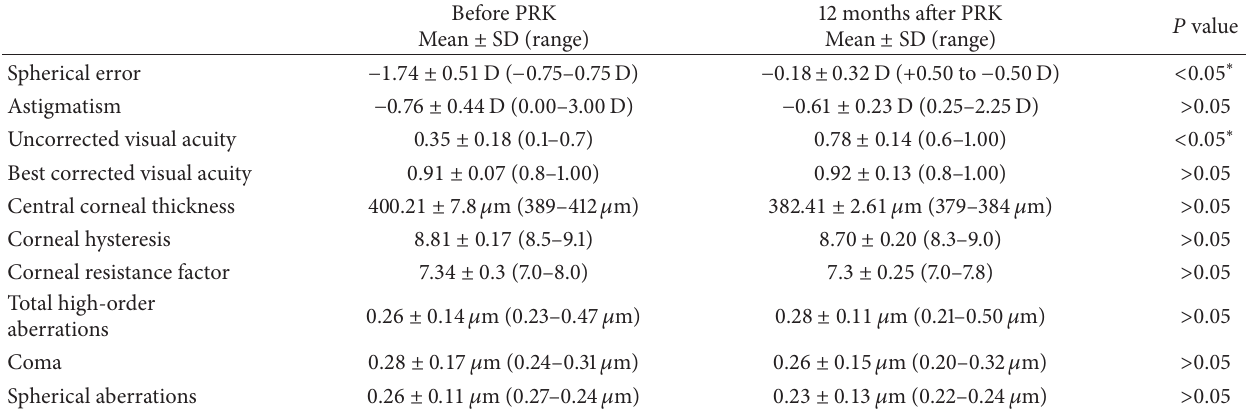
Table 1: Preoperative and 12-month postoperative data of eyes included in the